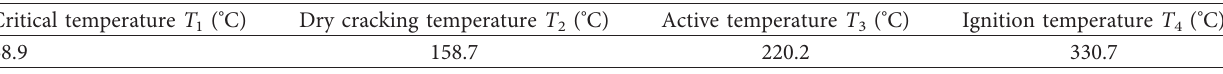
Table 2: Values of characteristic temperatures for the Bulianta 12# raw coal sample at a heating rate of 10 ° C/min in air. Critical temperature T 1 ( °